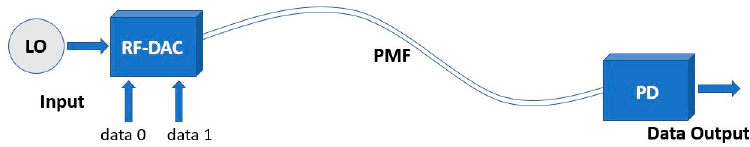
Figure 1. Overview of the PMF